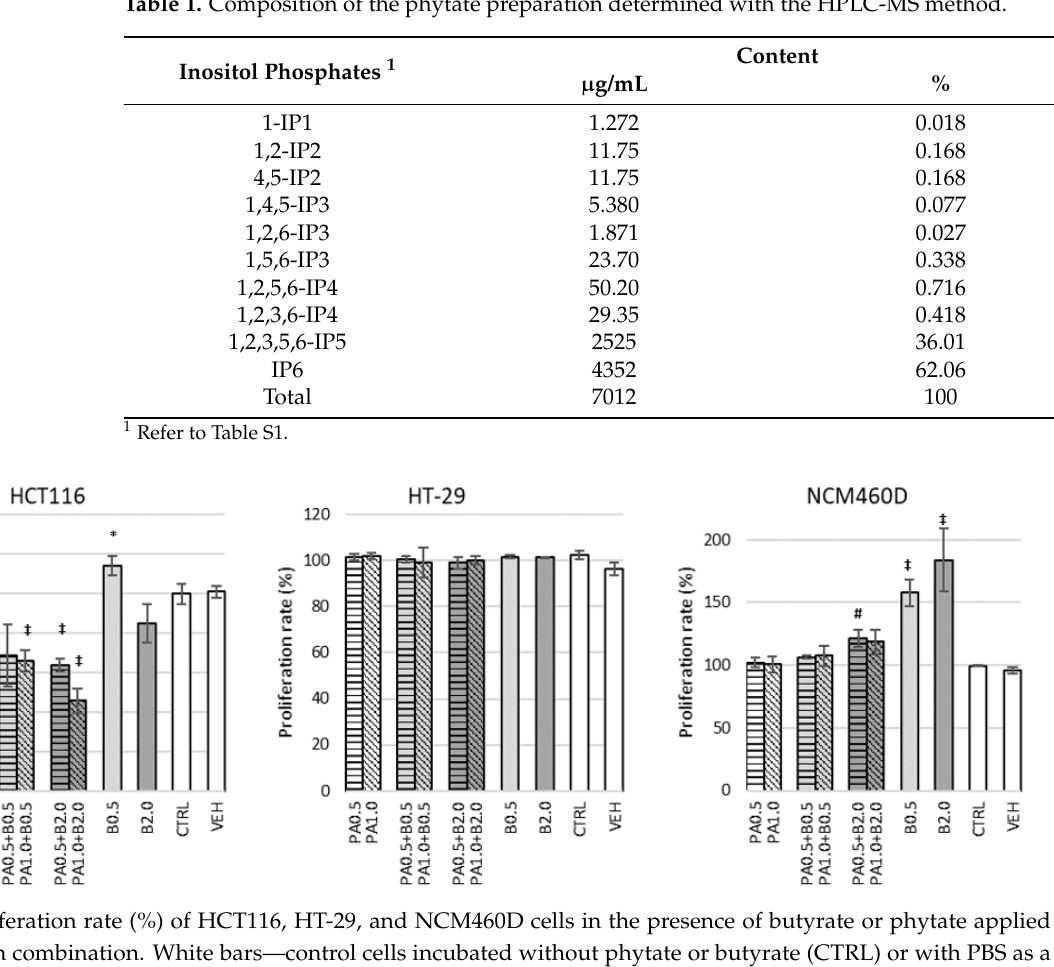
Table 1. Composition of the phytate preparation determined with the HPLC-MS method.